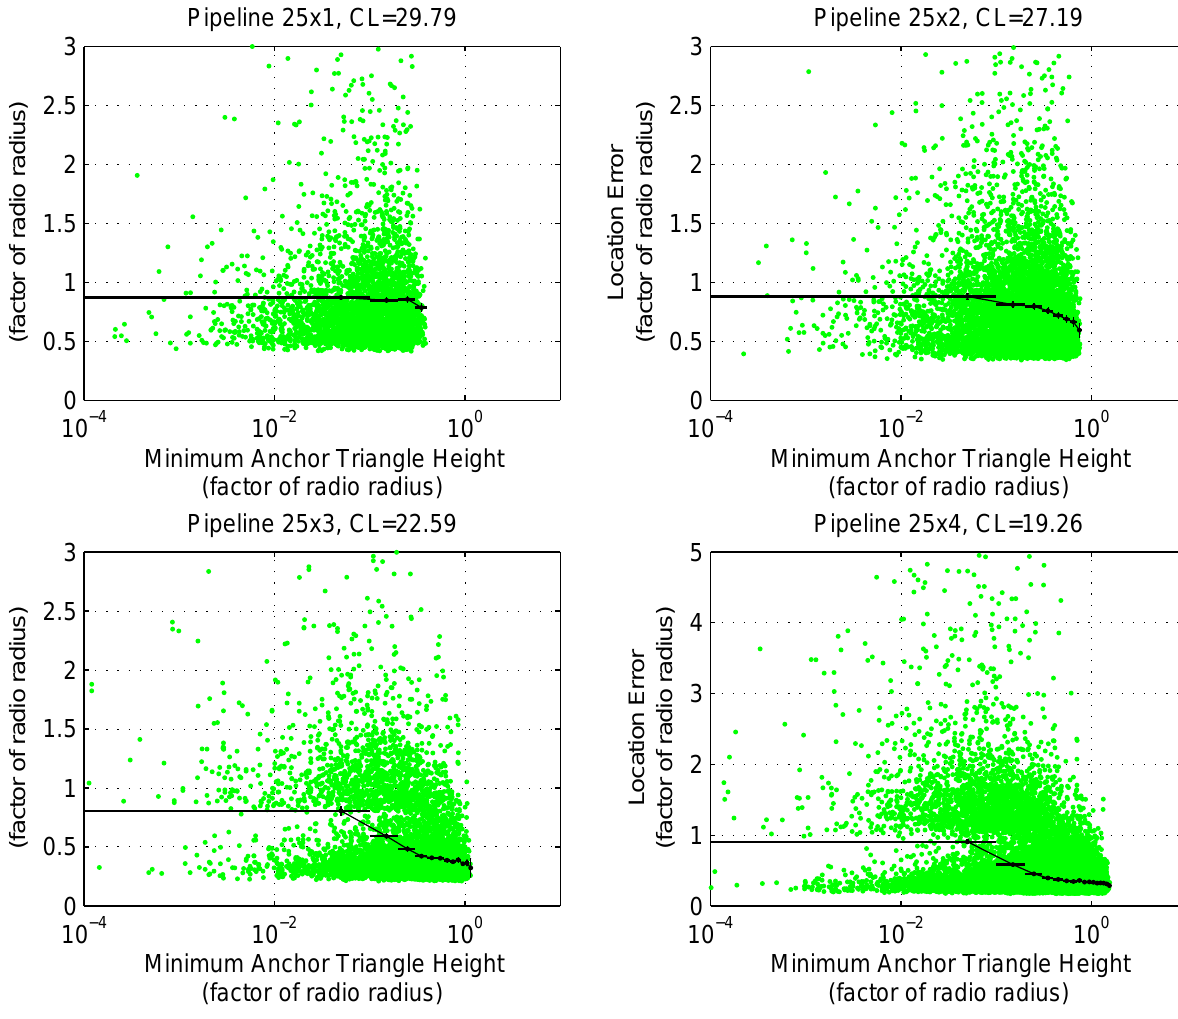
Figure 9. Minimum height of anchor triangle vs . mean localization error for random pipeline 25-by-1,2,3 and 4 unit networks with 200 nodes, 1,000 anchor sets each, and a radio range of 2.0